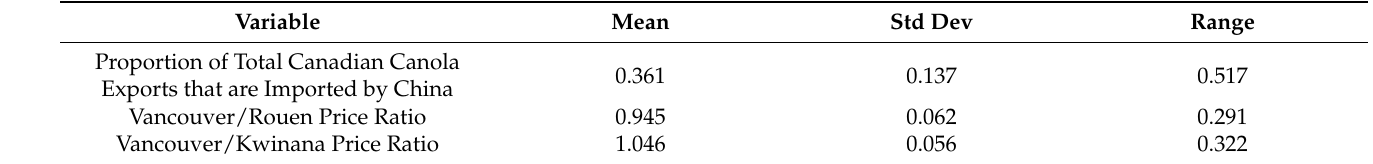
Table 1. Summary